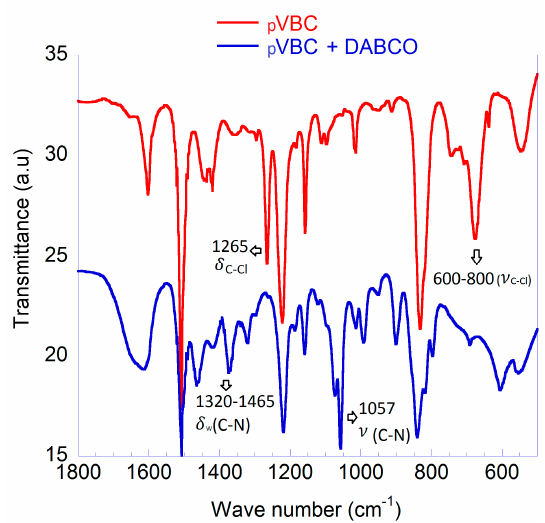
Figure 4. Characterization of pVBC and pVBC-DABCO; FTIR spectroscopy.